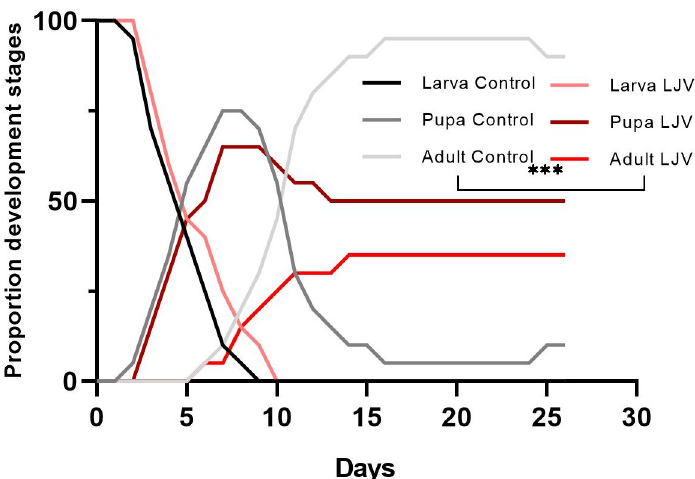
Figure 4. Characteristics of Ds larvae following the oral administration of LJV. The untreated control group is shown in shades of gray (black = larvae, dark gray = pupae, and light gray = adults). The LJV-infected group is shown in shades of red (pink = larvae, dark red = pupae, bright red = adults). The data were analyzed by two-way ANOVA. Statistically significant differences are shown at *** p < 0.001.